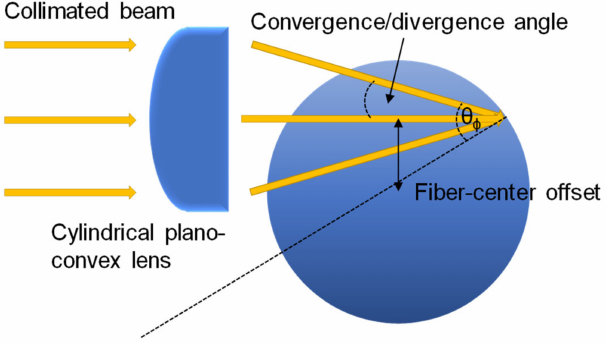
Figure 8. Example variations of the sensing mechanism and measurands for skew-ray-based